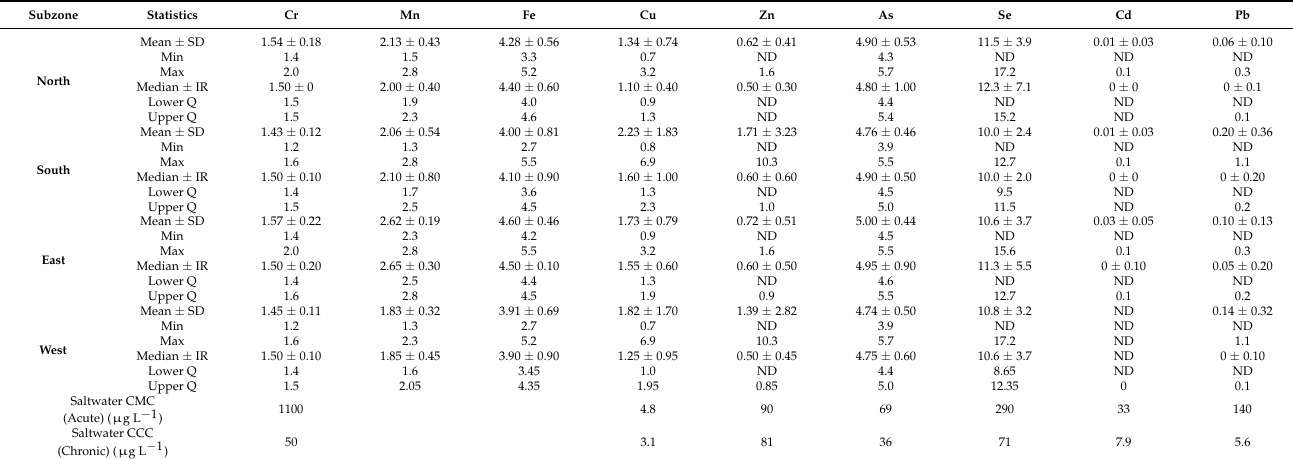
Figure 4. Biplot of the two main components obtained by principal component analysis (PCA) representing both water samples and detected elements. Table 2. Statistics (mean ± standard deviation, minimum, maximum, median ± interquartile range, and lower and upper quartiles) for elements detected ( µ g L − 1 ) separated by cardinal points in the Vigo estuary. Subzone